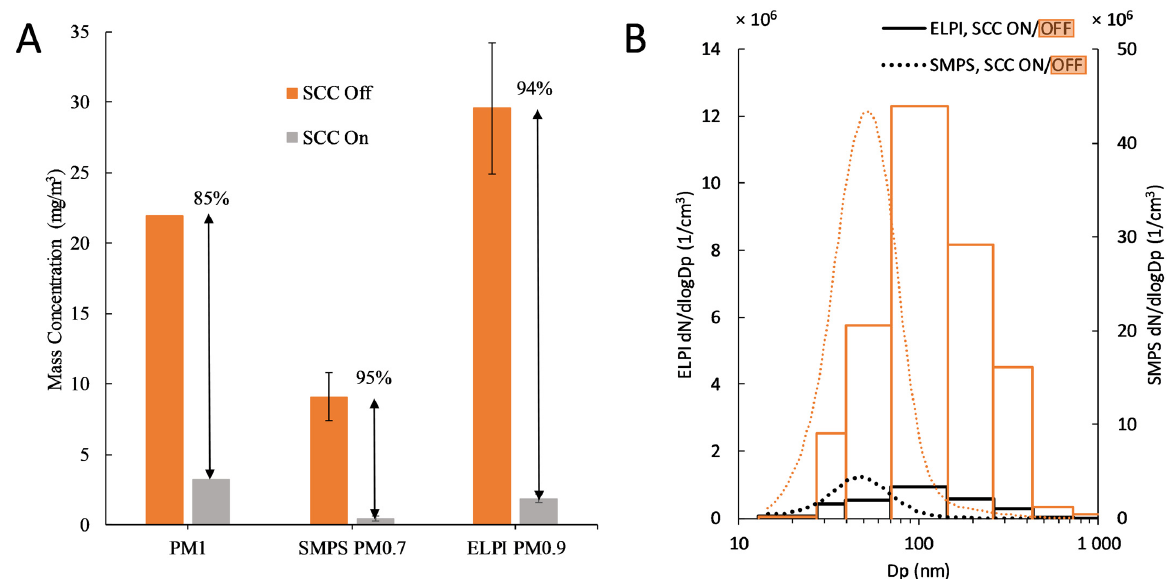
Figure 5. ( A ) Fine particle mass concentrations and ( B ) particle size distributions downstream of the condensing heat exchanger (CHX) in a short-term measurement using the SCC at a flue gas temperature of 400–500 °C, voltage 45 kV DC, and sheath air 20 dm 3 /min.